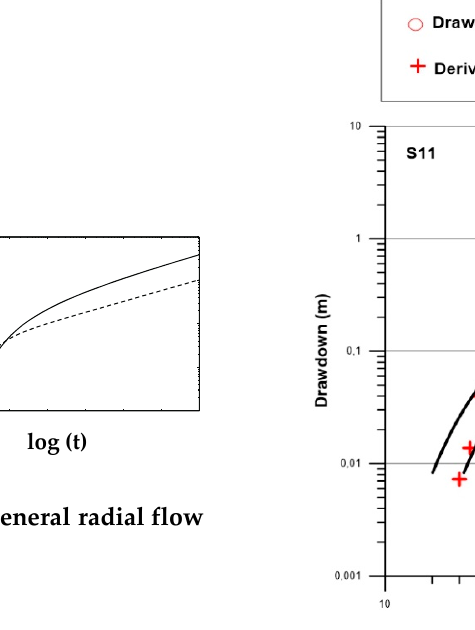
Figure 14. Interpretation of pumping test S10/S11: diagnostic plot ( left ) and data superimposed with a fitted Barker model ( right ).